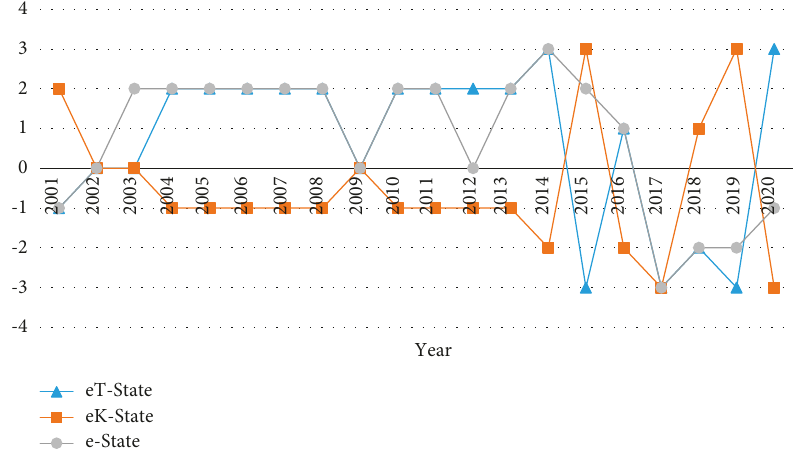
Figure 24: Decoupling of energy efficiency, energy structure, and carbon emission of mining industry from 2001 to 2020.